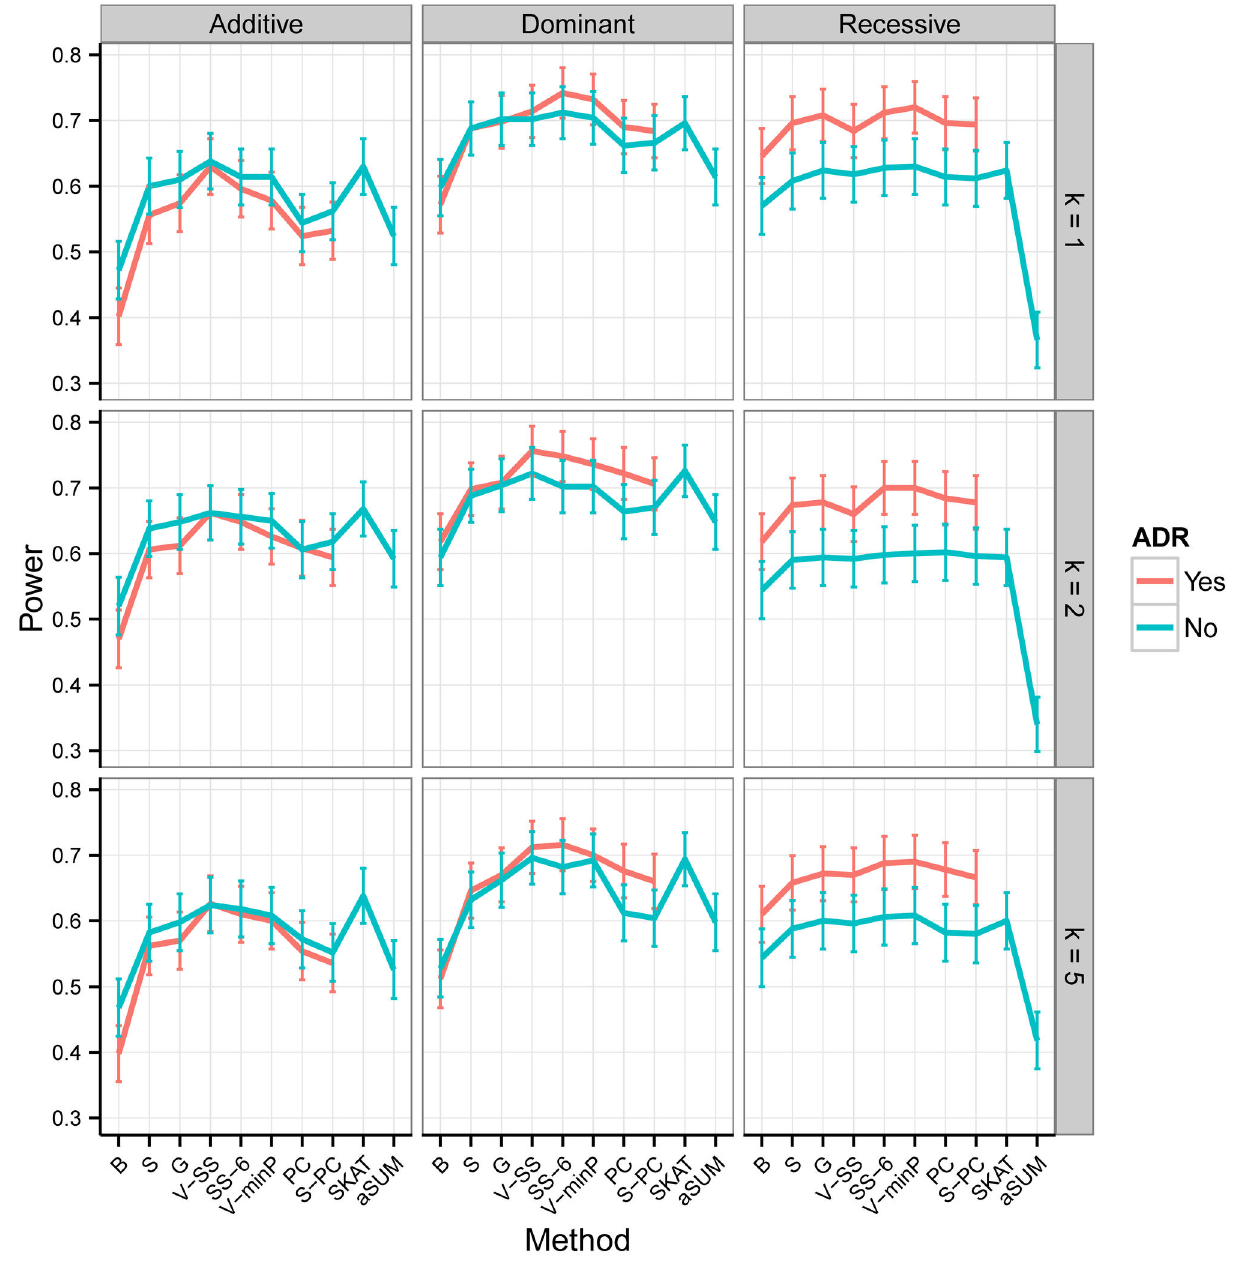
Figure S1. The size of the test under Experiment I as a function of the method type, the number of SNPs ( m ), the polychoric correlation (ρ) between the genotypes of